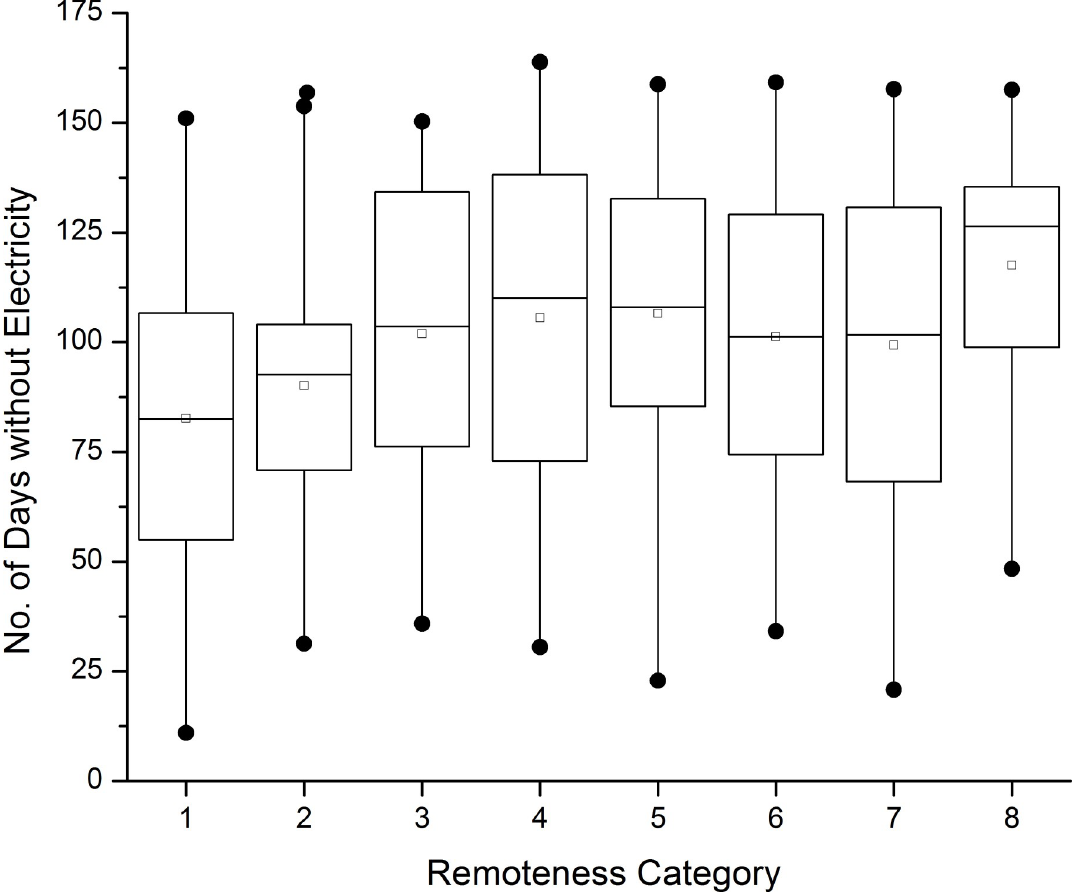
Fig 4. Distribution of NDWE according to remoteness category. Box plots show the medians (dark bars) of recovery time for barrios in different remoteness categories. Recovery time progressively increases as remoteness increases (from category 1, least remote, to 8, most remote. Boxes indicate the interquartile range (25/50/75 percentiles); vertical lines indicate the min/max range, and points denote